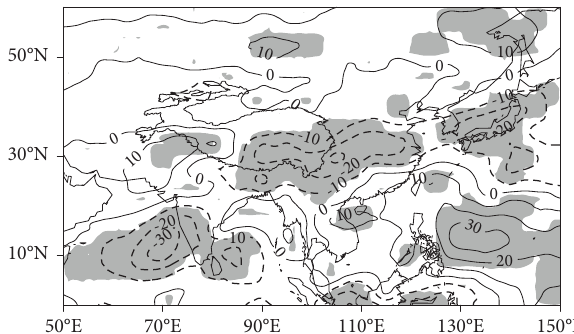
Figure 8: Diference synthetic feld of OLR of strong AHS/weak westerly-monsoon year and weak AHS/strong westerly-monsoon year (unit: w/m 2 , shadow indicates passing 95% reliability